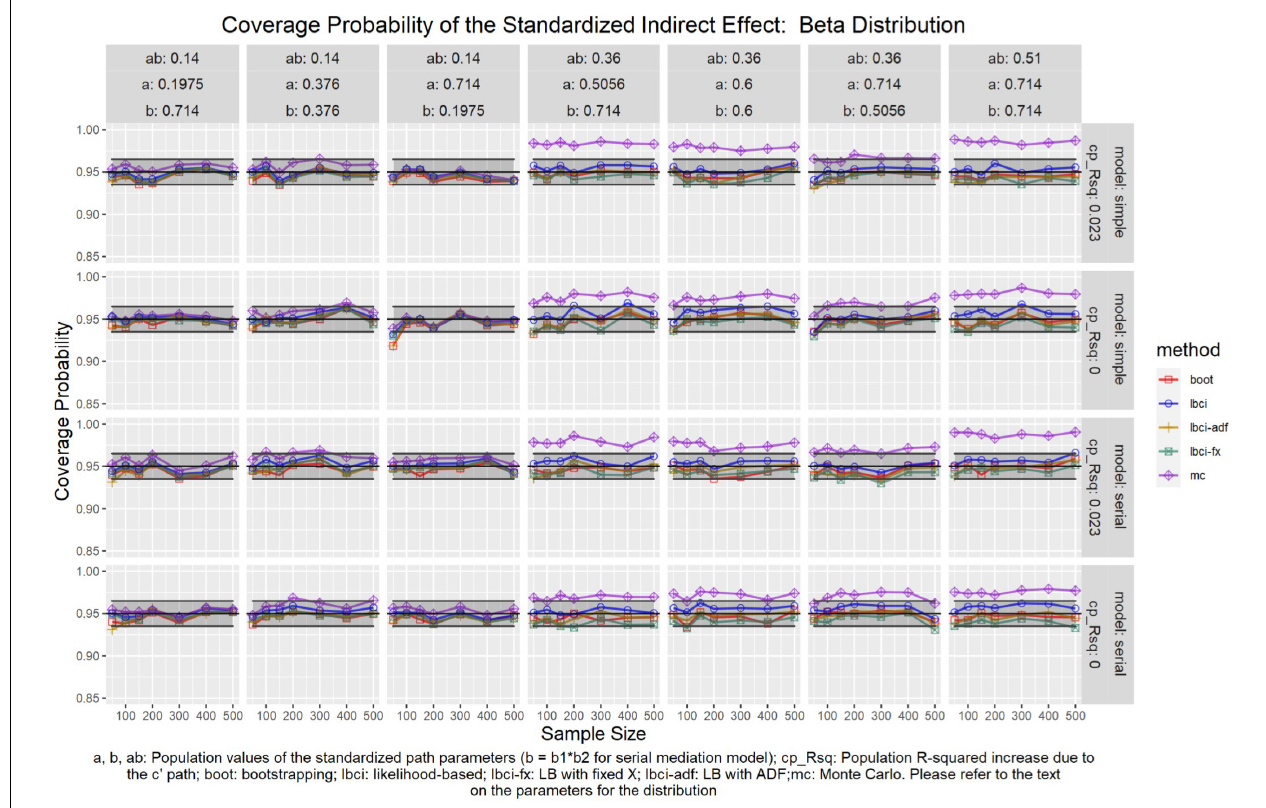
FIGURE 11 | Beta Distribution (Standardized Indirect Effect). a, b, ab: Population values of the standardized path parameters (b = b1 × b2 for serial mediation model); cp_Rsq: Population R-squared increase due to the c (cid:48) path; boot: bootstrapping; Ibci: likelihood-based; Ibci-fx: LB with fixed X; Ibci-adf: LB with ADF;mc: Monte Carlo. Please refer to the text on the parameters for the